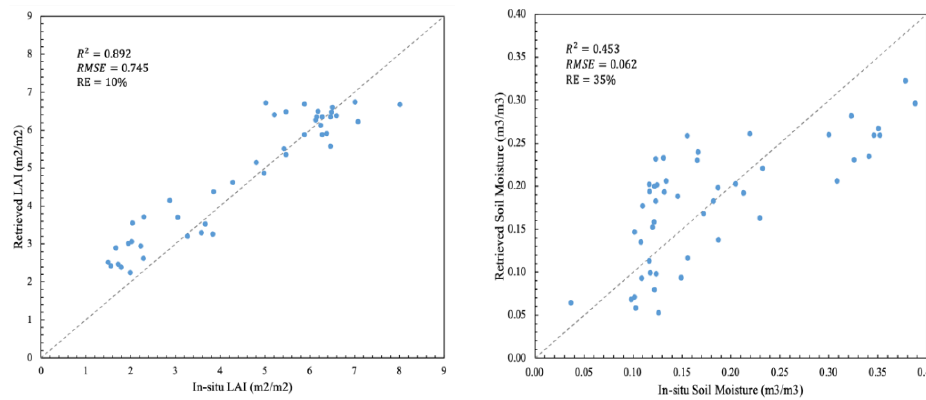
Figure 3. Scatterplot of retrieved LAI versus in situ LAI values ( left ) and retrieved SM versus in situ SM values ( right ) evaluated in the study area.